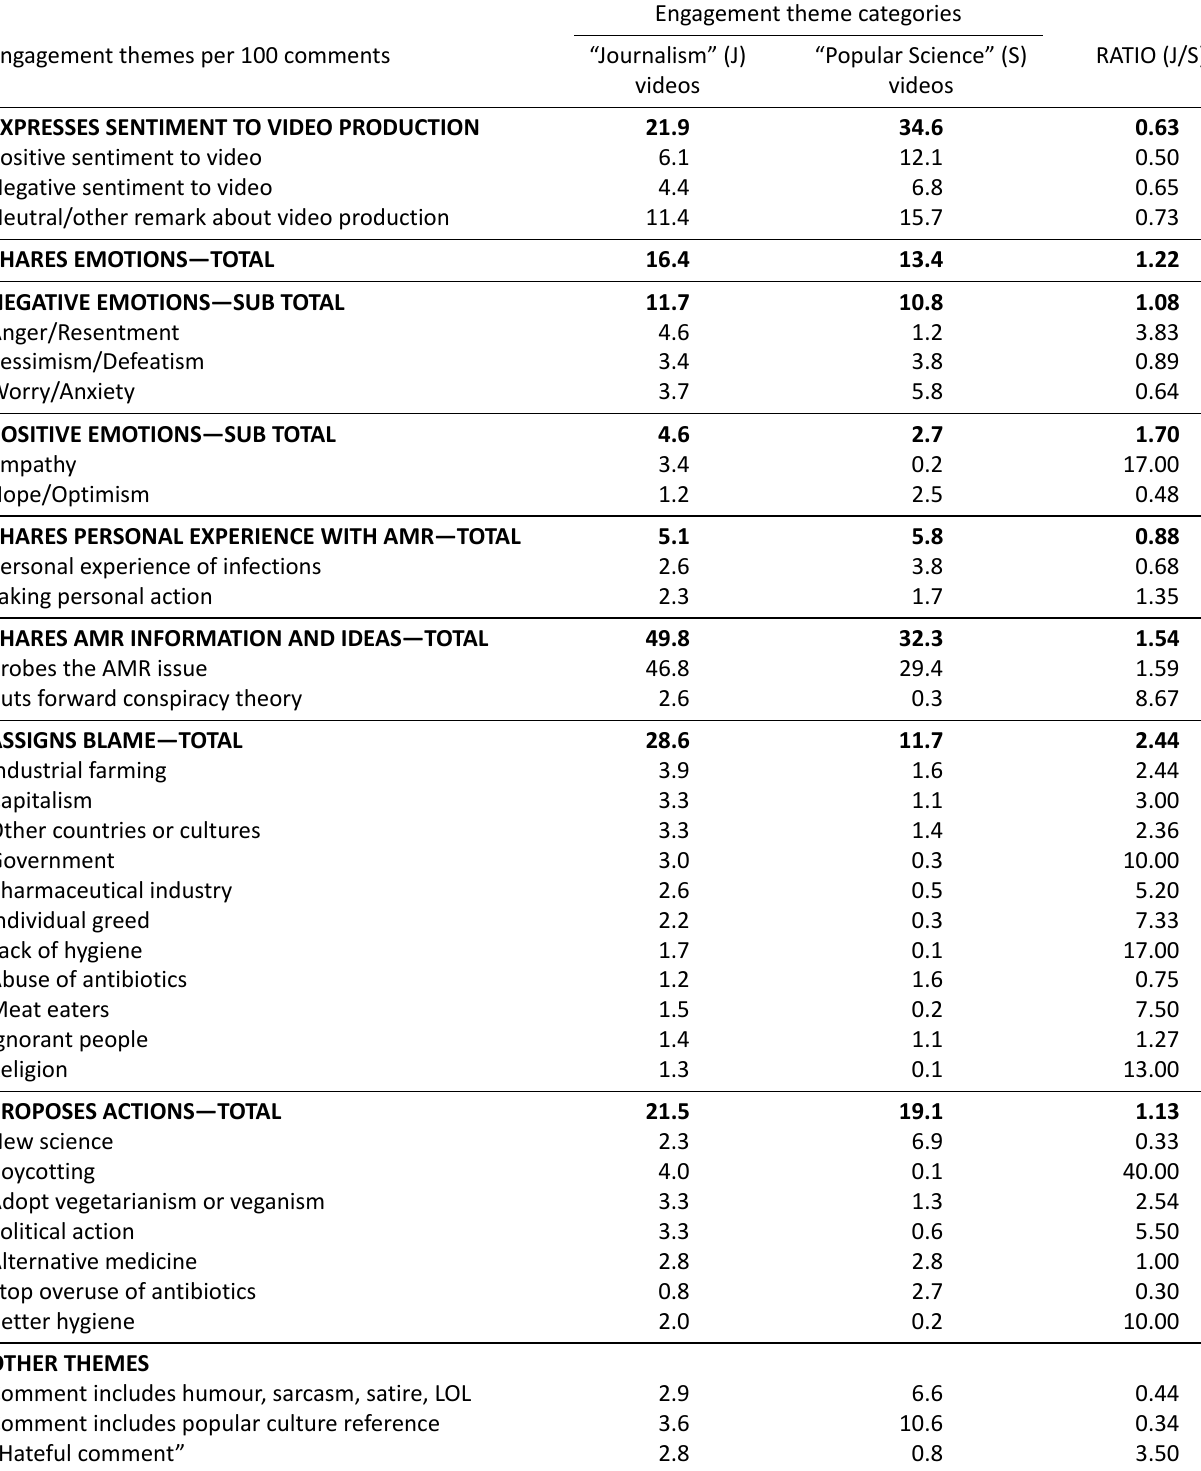
Table 3. Frequency of themes of engagement per 100 comments for journalism and popular science videos about AMR on